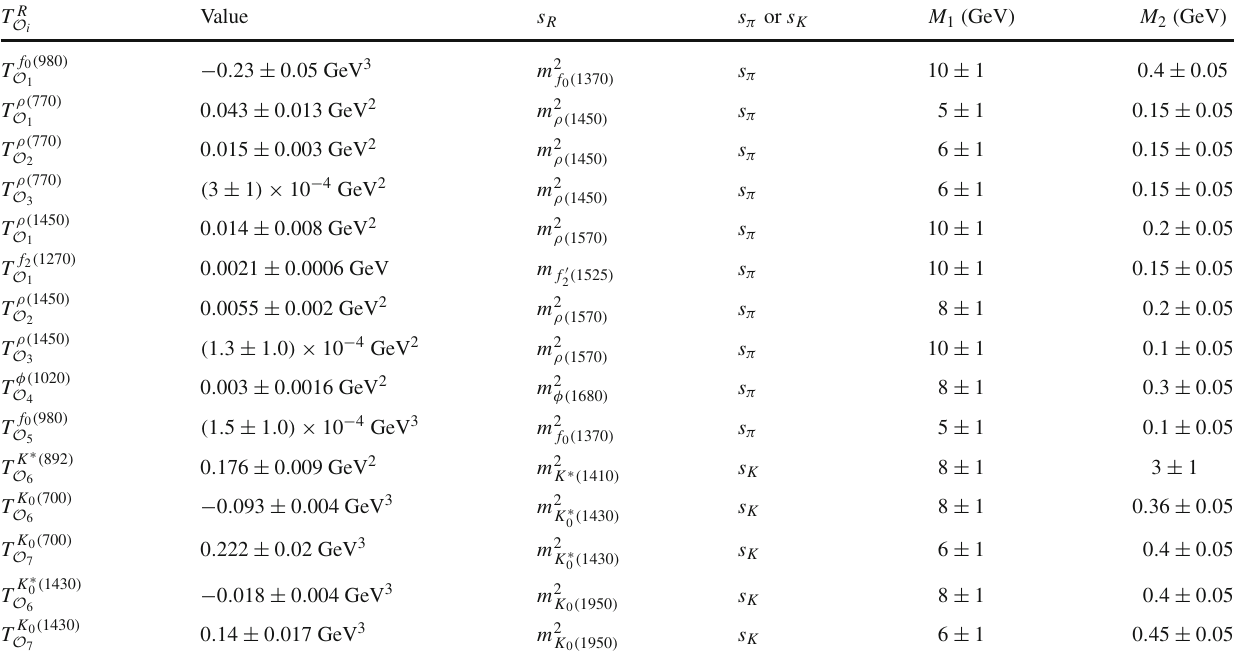
Table 1 Numerical results of the parameters for the matrix element (cid:5) R , M | O i | B − (cid:6) , where the threshold parameter for the final pion or kaon are s π = m 2 π( or s K = m 2 respectively K ( 1460 ) 1300 )